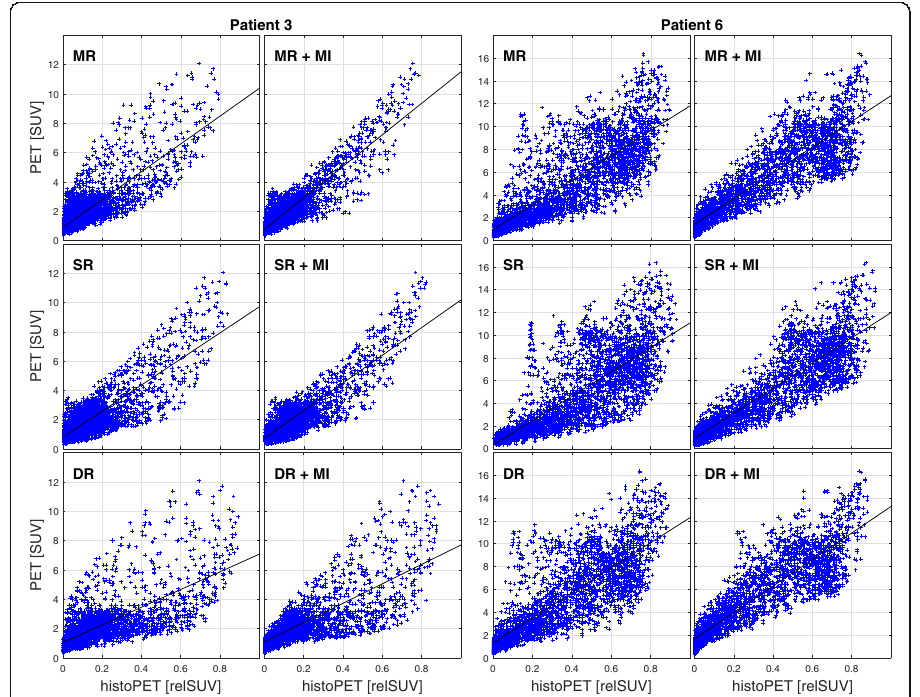
Fig. 6 Detailed pattern comparison of PSMA-PET and histoPET — example. The scatterplots present the correlations of voxels within the prostate region for patients 3 ( left columns) and 6 ( right columns) covering all examined coregistration procedures ManReg (MR), ScalReg (SR), and DefReg (DR) before and after MI,